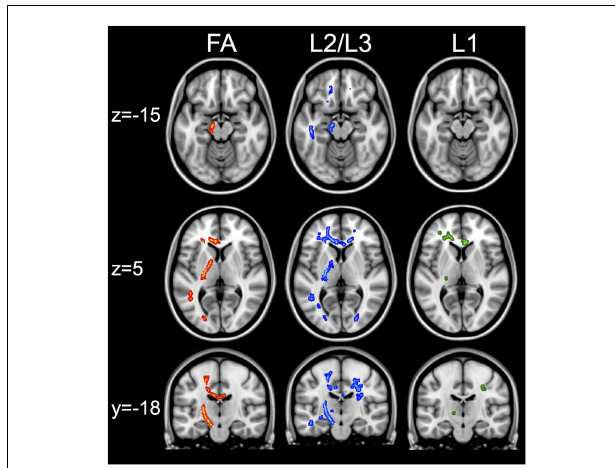
FIGURE 3 |White matter changes between healthy controls and patients . First column shows regions of interest in the corticospinal and transcallosal M1–M1 tracts that have greater FA in controls compared to patients. Second column shows the same regions of interest that show greater radial diffusivity (L2/L3) in patients compared to controls.The third column shows that in the same regions, there are no changes in axial diffusivity (L1) measures when comparing patients versus controls.The skeletonized results are thickened to aid visualization of results. All images show results that are significant at t > 3.1, p < 0.05 FWE using cluster